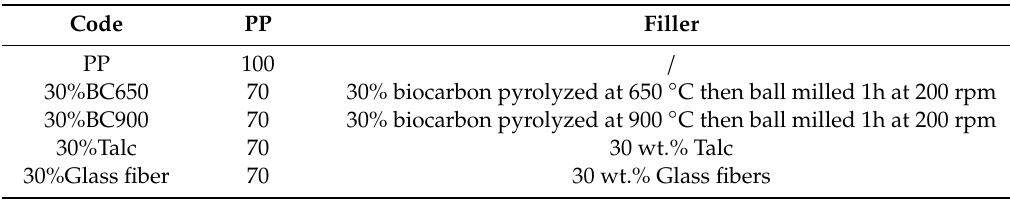
Table 3. Formulations prepared to contain 30 wt.%